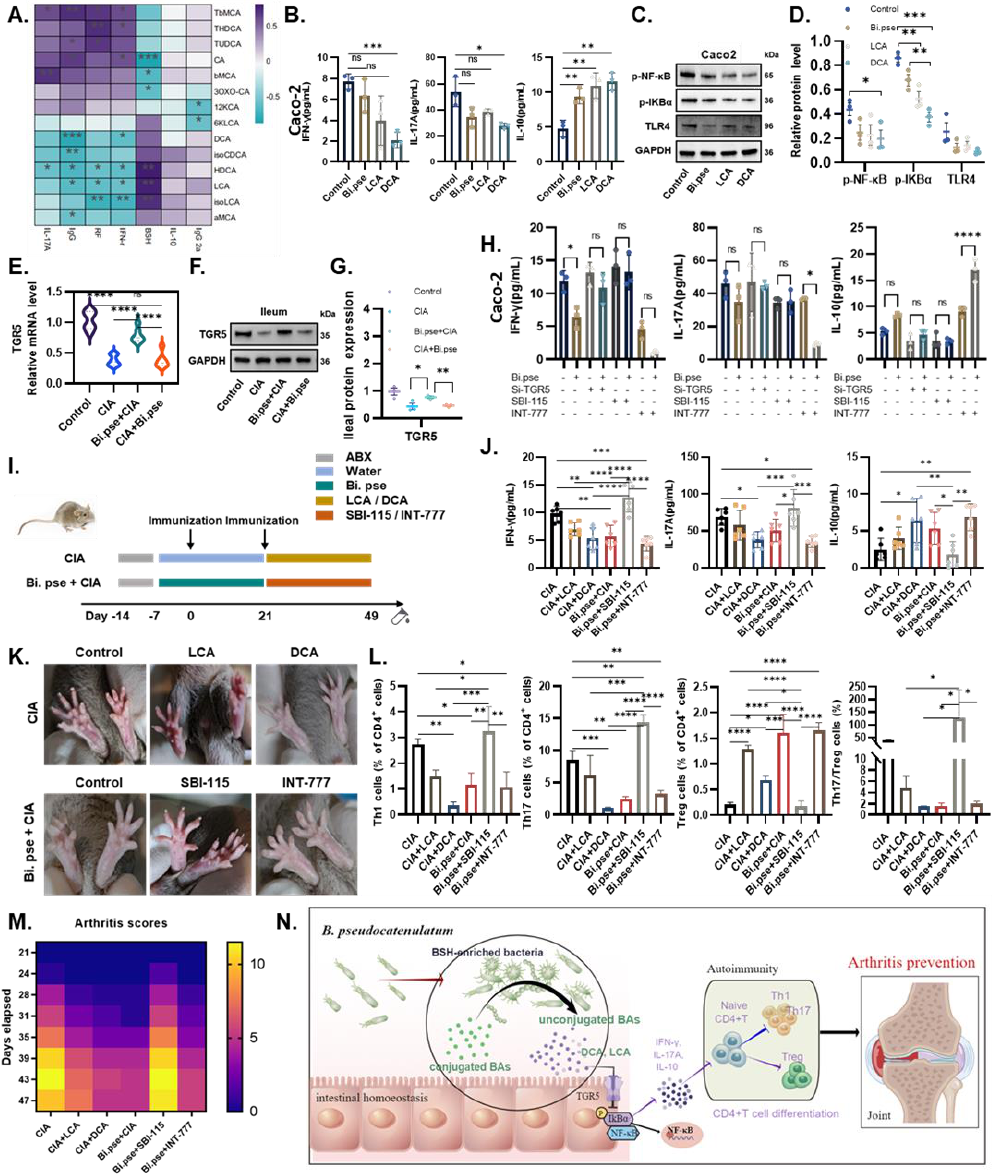
Figure 6. B. pseudocatenulatum -promoted DCA inhibits the alternative NF- κ B pathway by regulating TGR5 receptor expression. ( A ) Heatmap of positive (purple) and opposite (blue) correlation between BAs and cytokines. ( B ) The expression levels of IFN- γ , IL-17A, and IL-10 in culture supernatants of LPS-primed Caco-2 cells treated with B. pseudocatenulatum , LCA, and DCA. ( C , D ) Western blot shows the expression of NF- κB signaling pathway molecules. ( E ) Quantitative RT-PCR and ( F , G ) Western blot showing expression of ileum TGR5. ( H ) INT-777, a semi-synthetic TGR5 agonist, greatly enhanced the effect of B. pseudocatenulatum in inhibiting IL-17A and promoting IL-10 in LPS- stimulated Caco-2 cells. SBI-115, a TGR5 inhibitor, and si-TGR5 offset the inflammatory homeostatic effect of B. pseudocatenulatum . ( I ) Flow chart showing another experimental treatment design. ( J ) The concentrations of pro-inflammatory factors IFN- γ and IL -17A, and the anti-inflammatory factors IL- 10 in mice serum were determined by ELISA. ( K ) Representative images of paws in each group